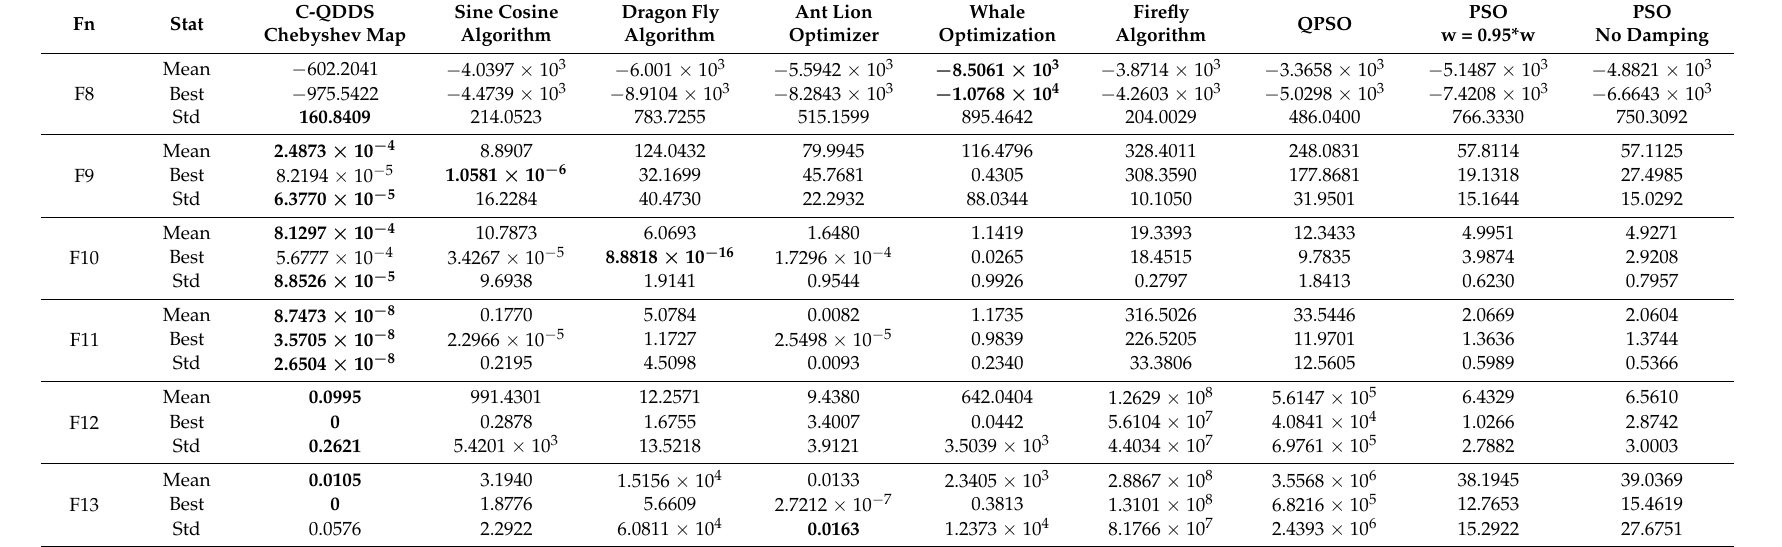
Table 11. Solution quality in multimodal functions in Table 3 (30D, 1000 iterations, 30 independent